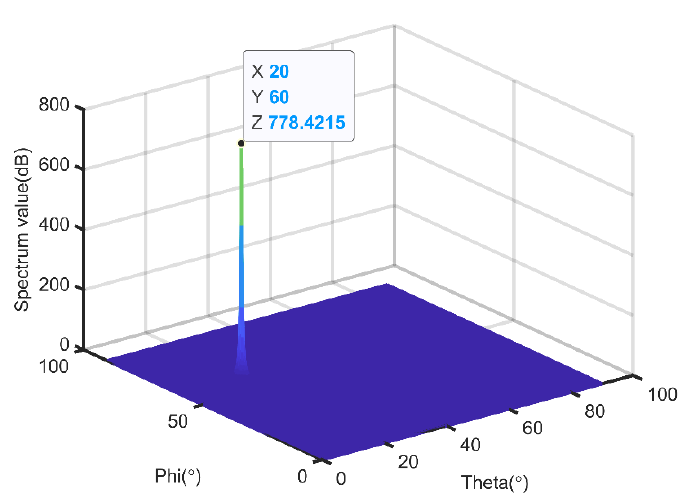
Figure 5. Schematic diagram of the data storage format.